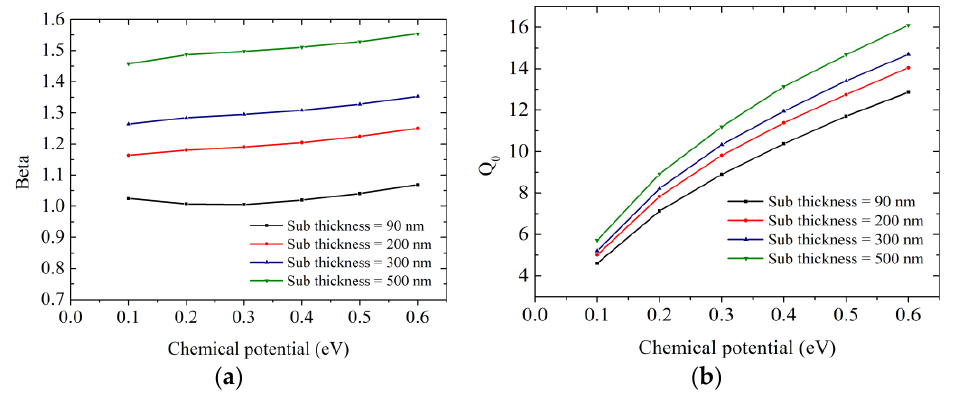
Figure 10. The calculated circuit parameter results versus chemical potential. ( a ) β and ( b ) Q 0 curves with different substrate thickness values, 90 nm, 200 nm, 300 nm, and 500 nm. The relaxation time is set as 0.5 ps, the arm length is 5 µm and the temperature is 300 K.